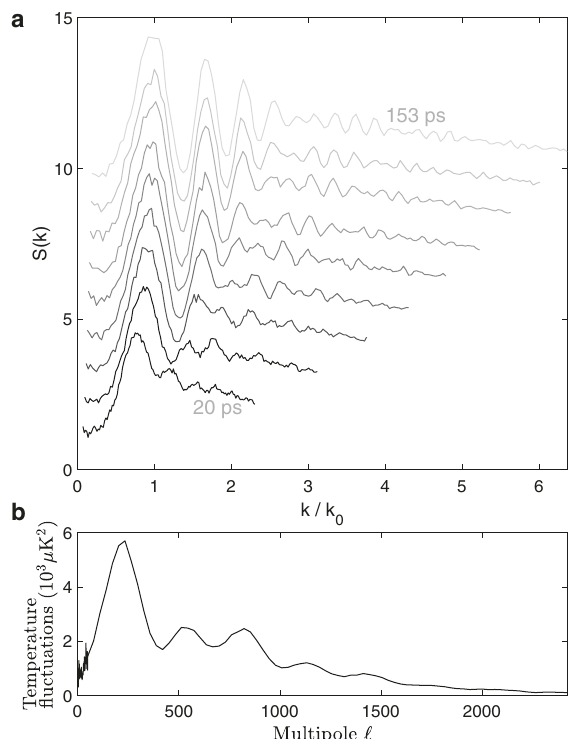
Fig. 5 Comparing the measured power spectrum with that of the CMB. a The static structure factor for τ > 0. The wavenumbers are normalized such that unity can be compared with the fi rst peak of the CMB spectrum in ( b ). b The power spectrum of temperature fl uctuations in the CMB, as a function of multipole number, from Ref. 36 .